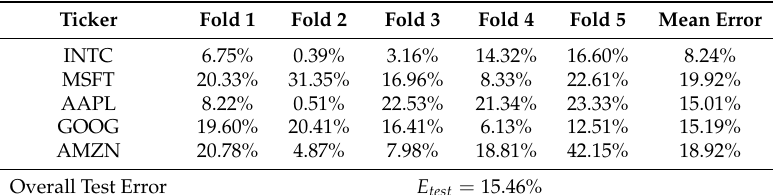
Table 10. Test Errors for different tickers by applying 5-fold cross-validation. The errors are percentage errors between benchmark coefficients and the MGCPP